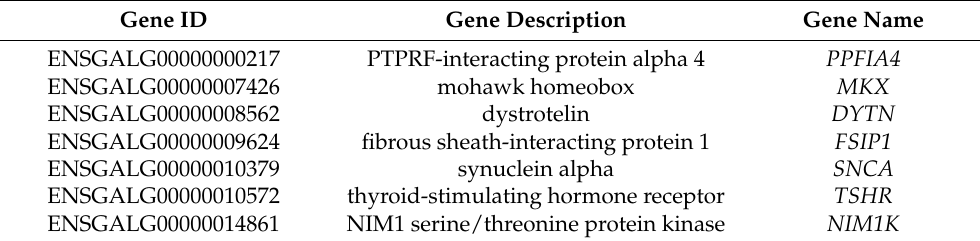
Table 1. Hub genes associated with H/L ratio in tan module in BY.